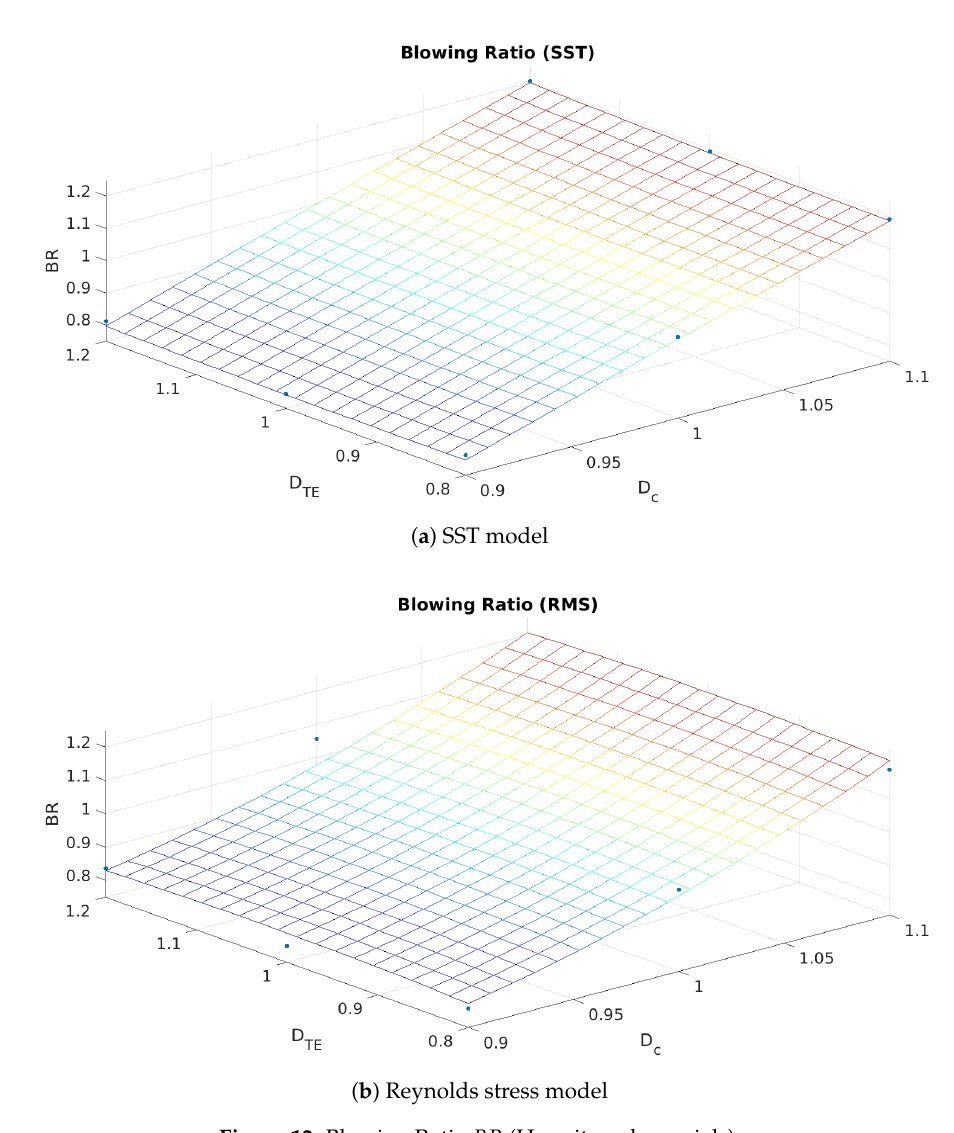
Figure 12. Blowing Ratio BR (Hermite polynomials).